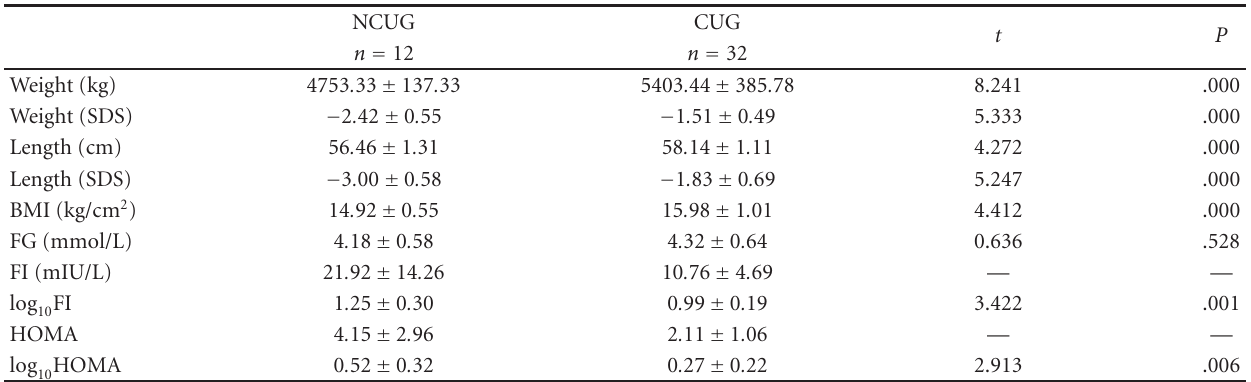
Figure 1: Correlation between change of weight Z-score during 3 months and logarithmically transformed HOMA at 3 months of age. The change of weight Z-score during 3 months was inversely related to the HOMA (logarithmically transformed) at 3 months ( r = − 0 . 318; P = . 035). Table 3: Comparisons of body size and shape and metabolic characteristics at 3 months of age between NCUG and CUG